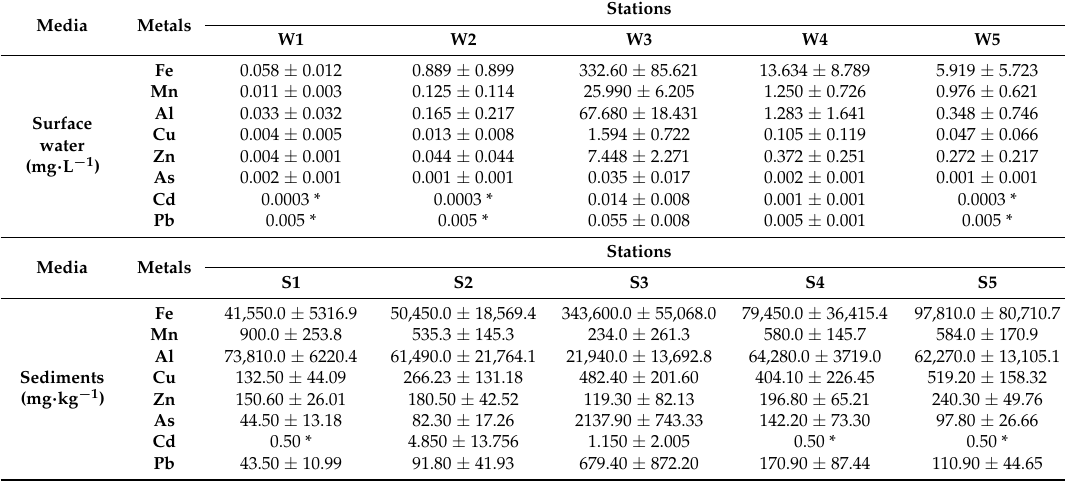
Table 2. The mean levels of the metals in the surface water and bottom sediments of the Smolnik